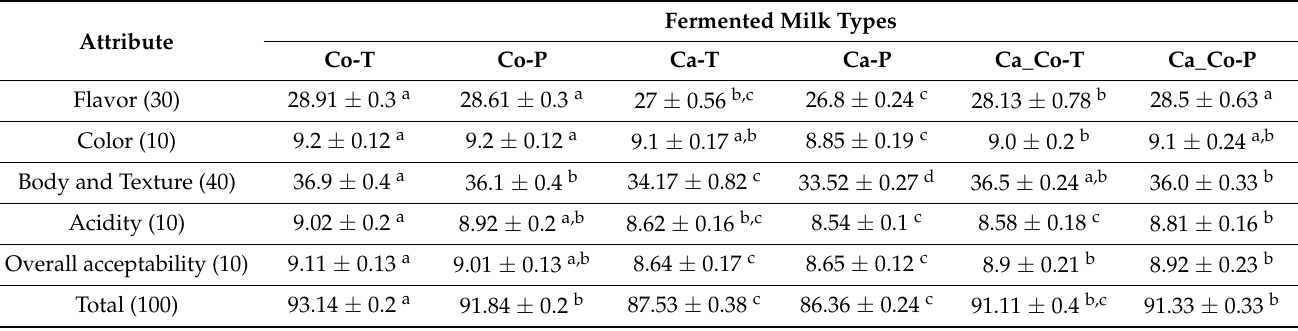
Table 2. Sensory evaluation of different fermented